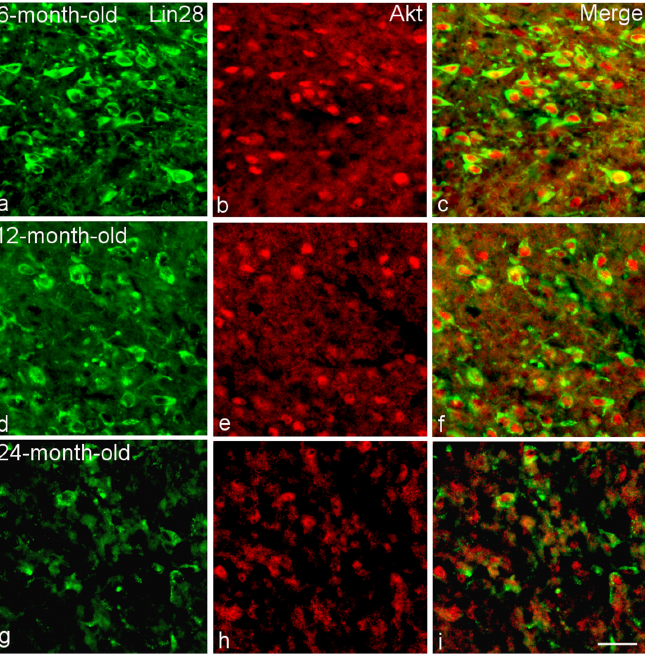
Figure 4. Colocalization of Lin28 with Akt in the VMH neurons of 6-month-old ( a – c ), 12-month-old ( d – f ) and 24-month-old ( g – i ) male rats. Double labeling of Lin28 ( a , d , g , green, left panel), Akt ( b , e , h , red, middle) and composite image ( c , f , i , right). Bar, 25 µm. The proportion of Lin28/PI3K-IR neurons significantly increased from 77 ± 1.2 in 2-month-old rat to 86 ± 1.0 in 6-month-old rats ( p < 0.05) and subsequently to 96–99% in 12-month-old and 24-month-old rats ( p < 0.01, statistically significant differences between 6-month-old and 12-month-old rats) (Figures 3 and 5). Differences between 12-month-old and 24-month-old rats were not statistically significant ( p > 0.05). Int. J. Mol. Sci. 2022 , 23 , 13468